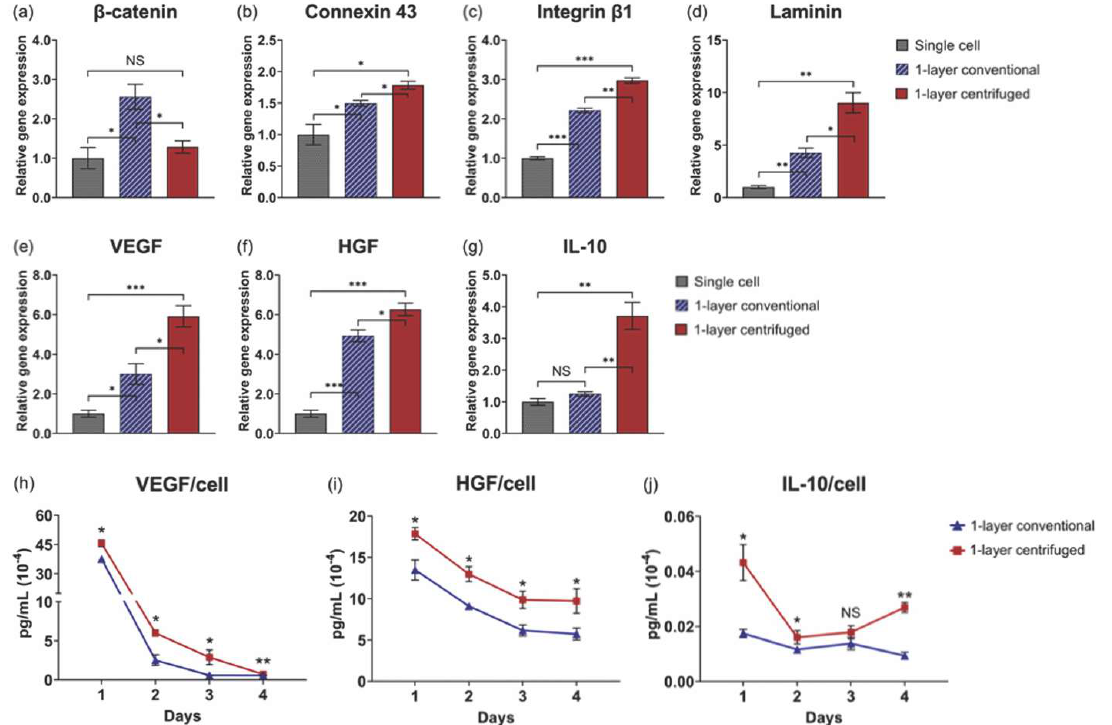
Figure 4. Cell sheet centrifugation enhances MSC pro-regenerative cytokine production related to cellular interactions. Quantitative gene expression of proteins related to cellular interactions, including ( a ) β -catenin (cell–cell interaction), ( b ) connexin 43 (gap junction), ( c ) integrin β 1 (cell–ECM interaction), and ( d ) laminin α 5 (ECM), and to cytokine production, including ( e ) VEGF, ( f ) HGF, and ( g ) IL-10, in conventional and centrifuged cell sheets at 24 h relative to the single cell suspension control. Analysis of cell sheet supernatants in static culture quantified ( h ) VEGF, ( i ) HGF, and ( j ) IL-10 secretion per sheet over 4 days, normalized to day 1 average viable cell number. Gene expression is normalized to GAPDH and compared to the single cell formulation of MSCs. Values are means ± SE (* p < 0.05, ** p < 0.01, and *** p < 0.001). NS = not significant ( p >